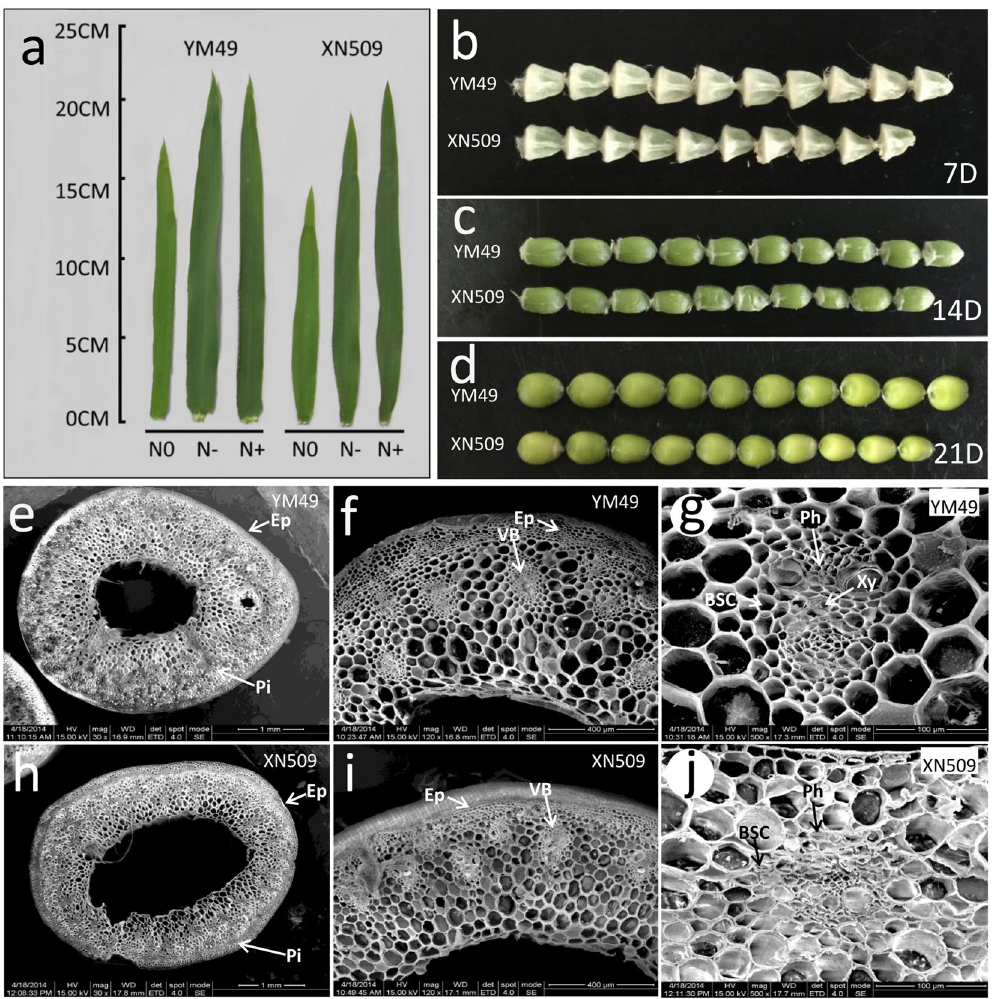
Figure 1. Phenotypic traits of the two wheat genotypes. ( a ) Leaf morphology of two wheat genotypes under various N conditions at the booting stage. ( b ) Kernel morphology of two wheat genotypes at 7D. ( c ) Kernel morphology of two wheat genotypes at 14D. ( d ) Kernel morphology of two wheat genotypes at 21D. ( e – g ) Morphological and structural observations of a stem section of YM49. ( e ) Overview of the Stem of YM49. ( f ) Overview of the Stem of YM49 containing a lateral vein. ( g ) Magnification of the vascular bundle (VB), showing the presence of bundle sheath cells (BSC), xylem (Xy) and phloem (Ph) of YM49. ( h – j ) Morphological and structural observations of a stem section of XN509. ( h ) Overview of the Stem of XN509. ( i ) Overview of the Stem of XN509 containing a lateral vein. ( j ) Magnification of the vascular bundle (VB), showing the presence of bundle sheath cells (BSC), xylem (Xy) and phloem (Ph) of XN509. Xy, xylem; Ph, phloem; BSC, bundle sheath cells; VB, vascular bundle; Pi, pith; Ep, epidermis. Note: Leaf was chosen from the flag leaves of the main stem at Feekes 10.0; kernel was chosen form the middle grain of the second spikelet for taking photos; the stem was chosen from the base of the second internode of the main